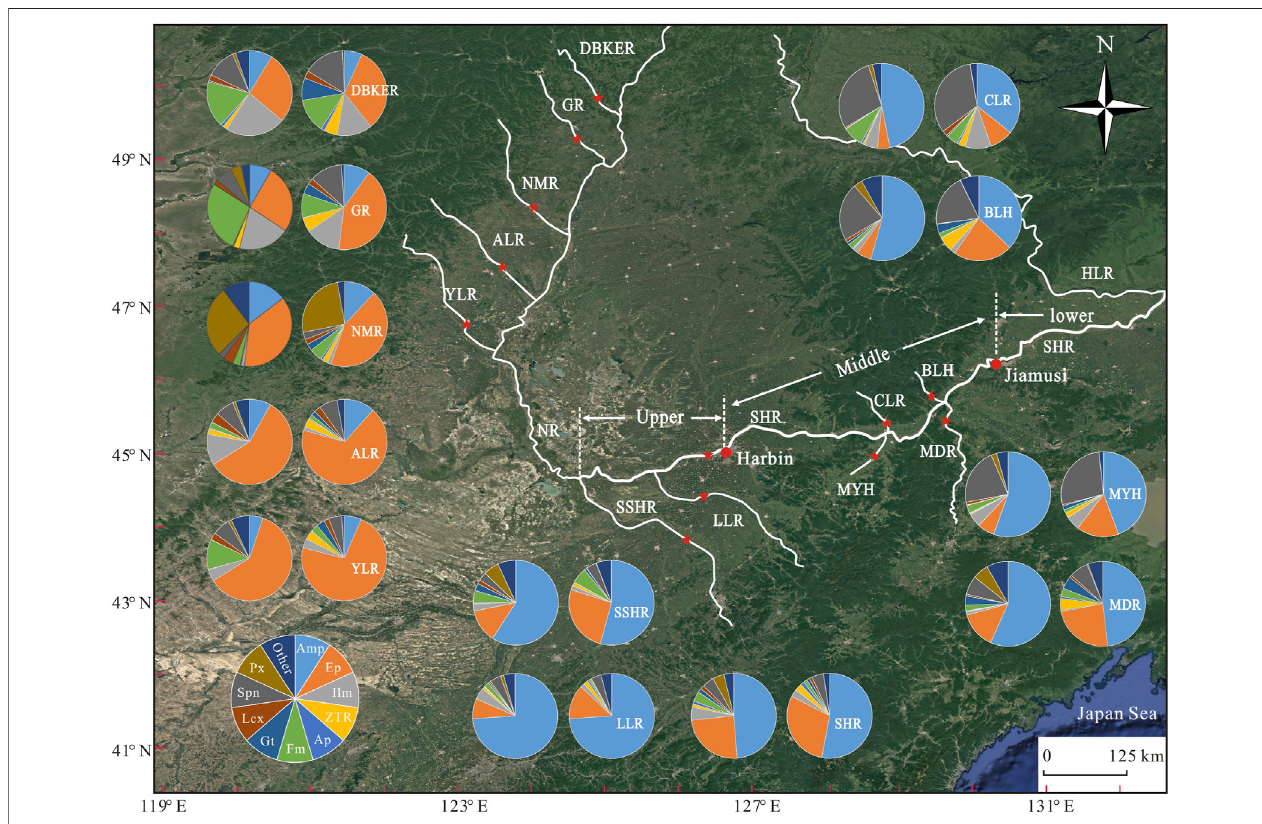
FIGURE 5 | A comparison composition of heavy mineral assemblages of the Songhua River based on the traditional optical (left) and TIMA (right) methods. Note thatmoreabundantepidoteandZTRmineralsinTIMAresults.Abbreviationde fi nitionssee Panels1 , 3 .(Forinterpretationofthereferencestocolourinthis fi gurelegend, the reader is referred to the web version of this